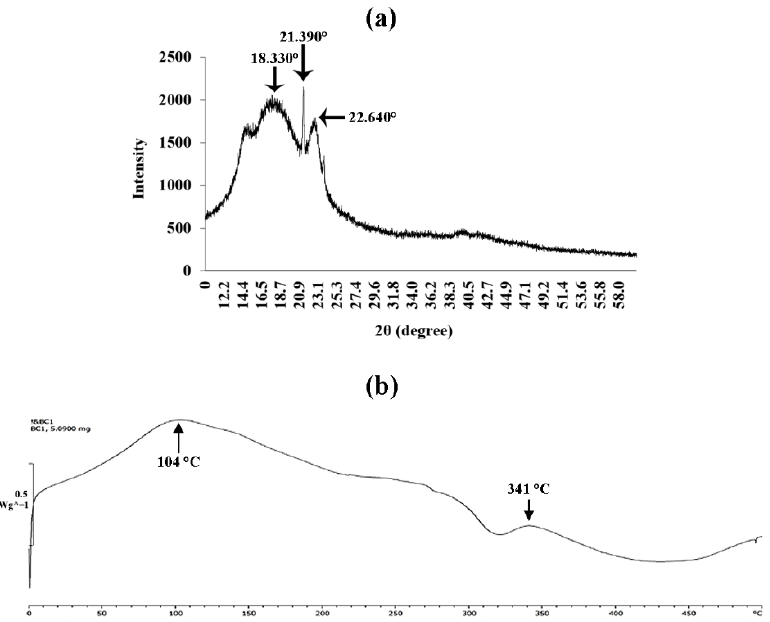
Figure 9. X-ray diffraction diagram ( a ); and DSC spectrum ( b ) of bacterial cellulose obtained from K. maltaceti P285 cultivation in HS medium and incubation at 30 °C for 21